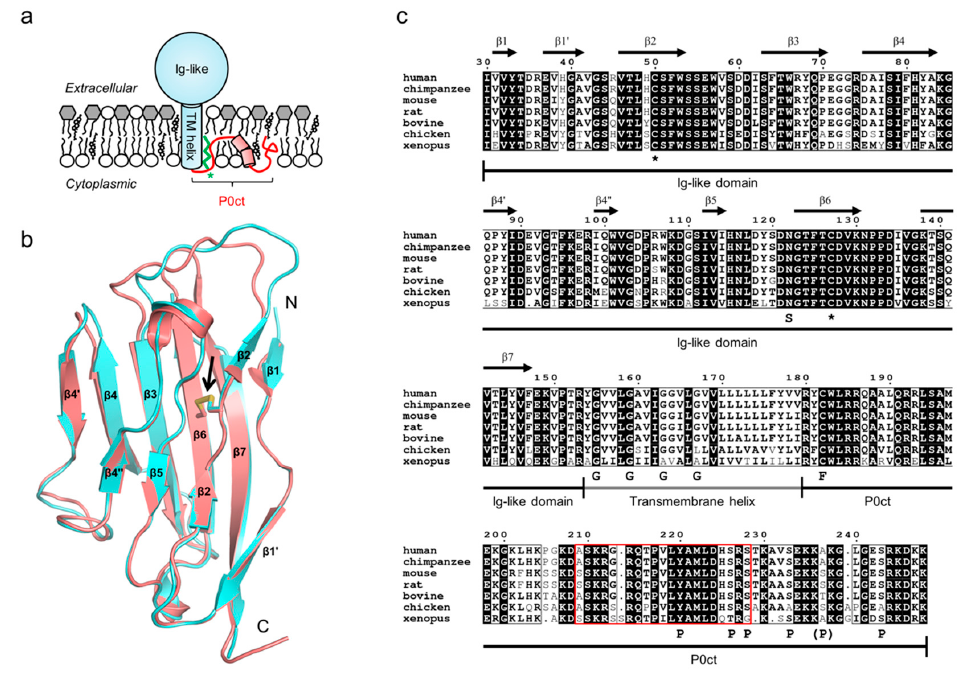
Figure 1. The molecular structure and conservation of P0. ( a ) The domain architecture and membrane topology of P0. The individual protein domains are labeled, with the highly positively charged P0ct highlighted in red. Fatty acylation of P0ct is shown in green, with the position Cys182 in P0ct indicated with an asterisk. Phospholipids and glycolipids are shown with white and gray headgroups, respectively. TM, transmembrane. ( b ) Structures of the rat (blue; PDB ID 1NEU [37]) and human (red; PDB ID 3OAI [40]) P0 Ig-like domains. The conserved disulfide bridge is indicated with an arrow. ( c ) Sequence alignment of the predominant P0 isoform from selected vertebrates. The signal sequence has been omitted, and the numbering and secondary structure labels correspond to human P0. The disulfide-linked cysteines (asterisks), the fatty acylation site (F), the glycosylation site (S), and the Gly zipper (G) motif in the transmembrane domain are indicated. Known phosphorylation sites are labelled (P). The P-site in brackets is phosphorylated in mice but not conserved in humans [66]. The lines below the alignment denote the individual P0 domains. The P0ct neuritogenic segment is represented by the red box.